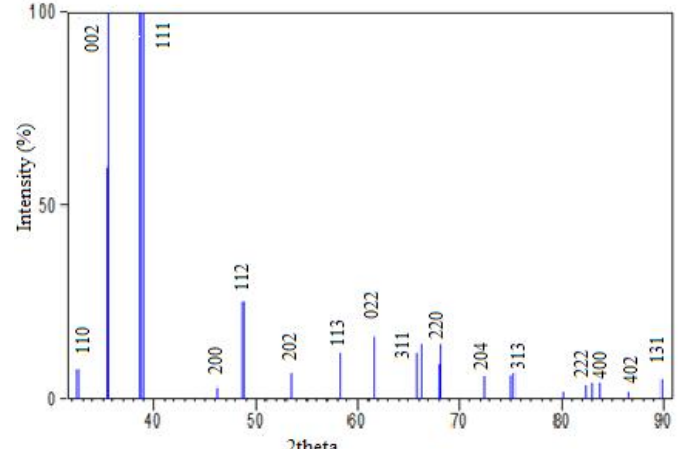
Fig. 9 XRD pattern of CuO nanoparticles prepared by calcinations of nano-powder of compound 1